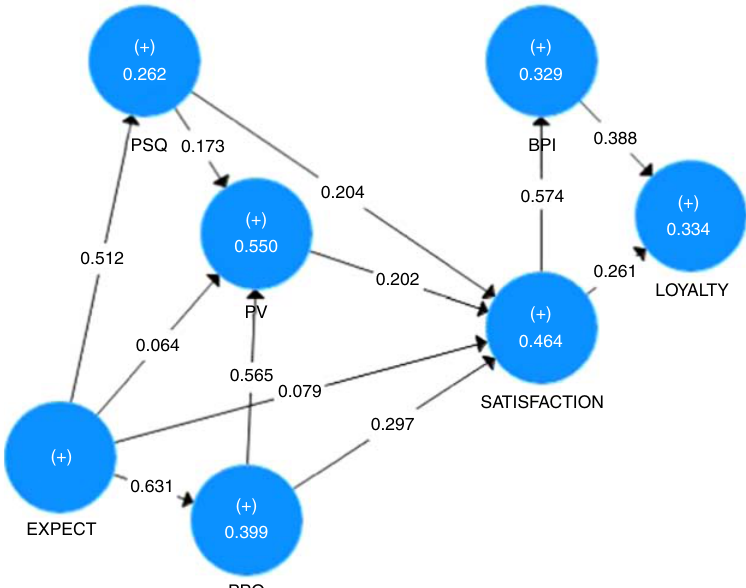
Figure 2. Structural model